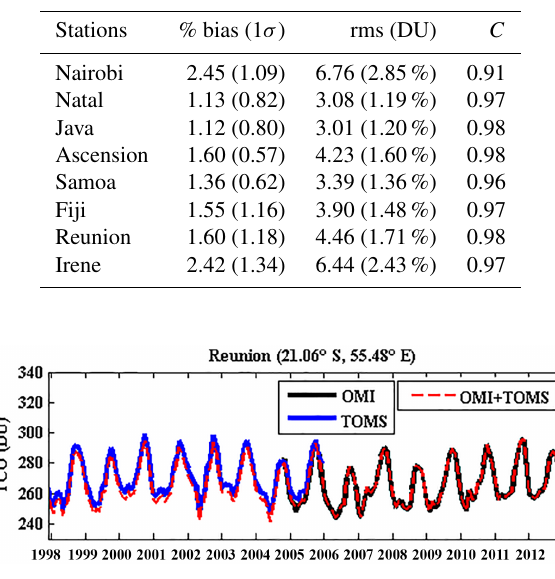
Table 2. The computed bias, rms (root mean square) and correla- tion coefficient C observed between OMI and TOMS for individual stations during the period from August 2004 to December 2006.